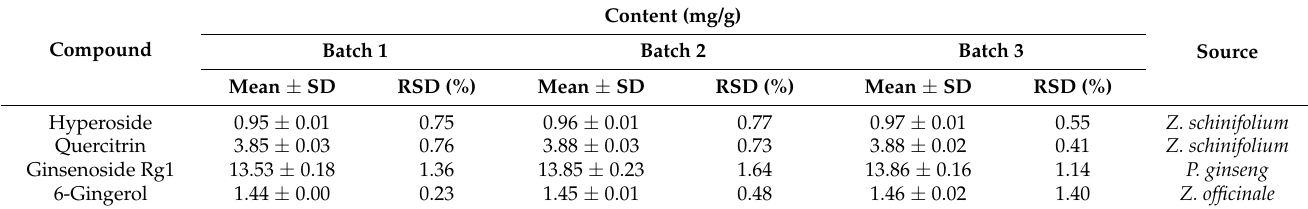
Table 4. Content of the four marker analytes in DGJT sample determined using HPLC ( n = 3).